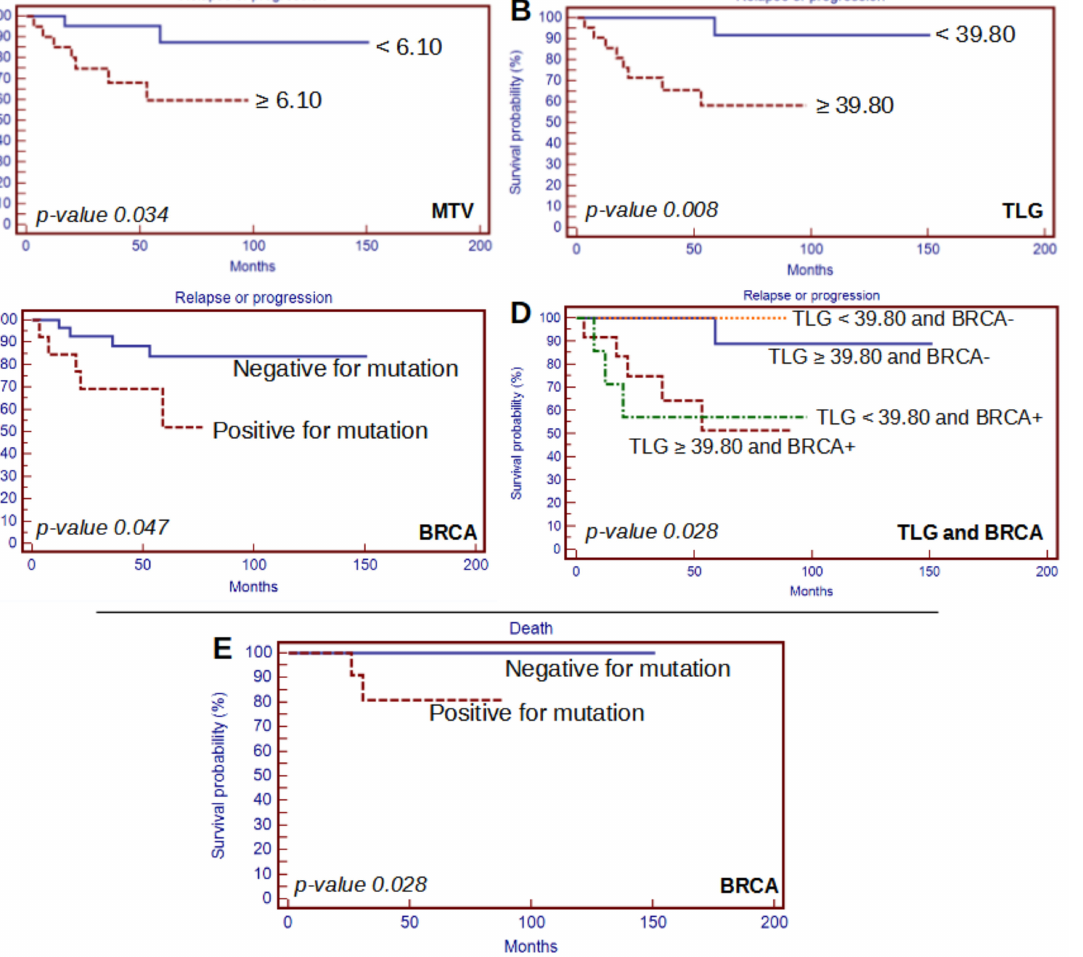
Figure 2. Significant survival curve analysis for MTV ( A ), TLG ( B ), BRCA status, ( C ) and TLG combined with BRCA status ( D ) regarding PFS and BRCA status regarding OS ( E